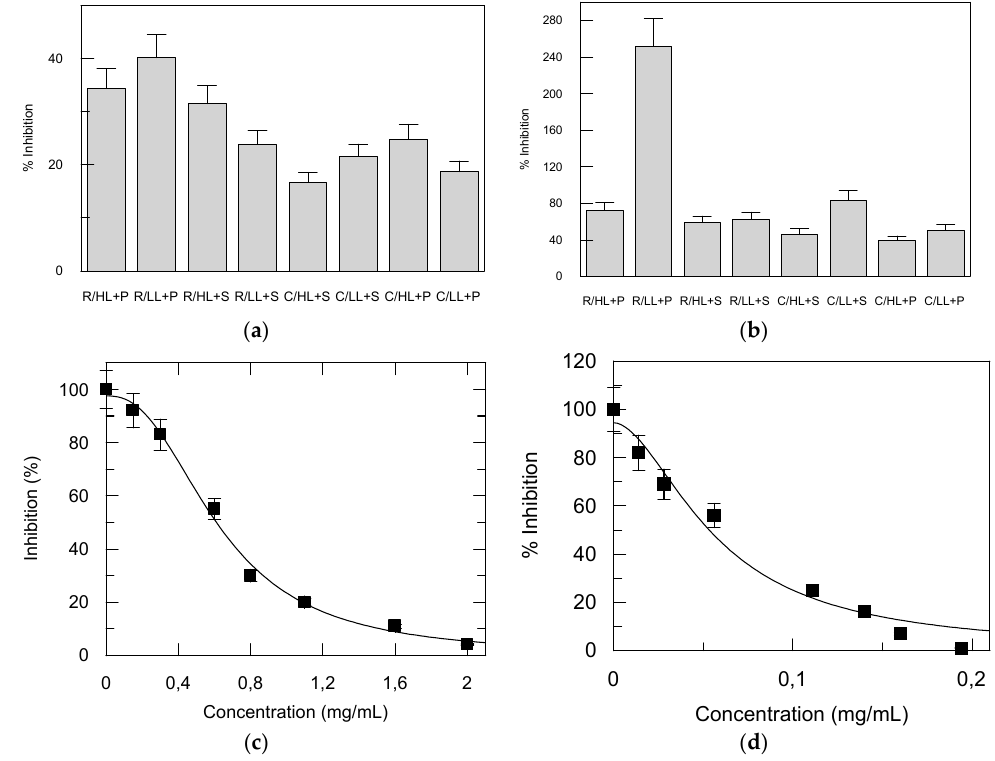
Figure 5. Tyrosinase ( a ) and elastase ( b ) inhibition of Rubus idaeus L. fruits extract from two cultivars (‘Ruvi’ and ‘Cayuga’) growing under different light conditions and substrate composition. Dose-response effect of R/LL + P extract on tyrosinase ( c ) and elastase ( d ) activity.